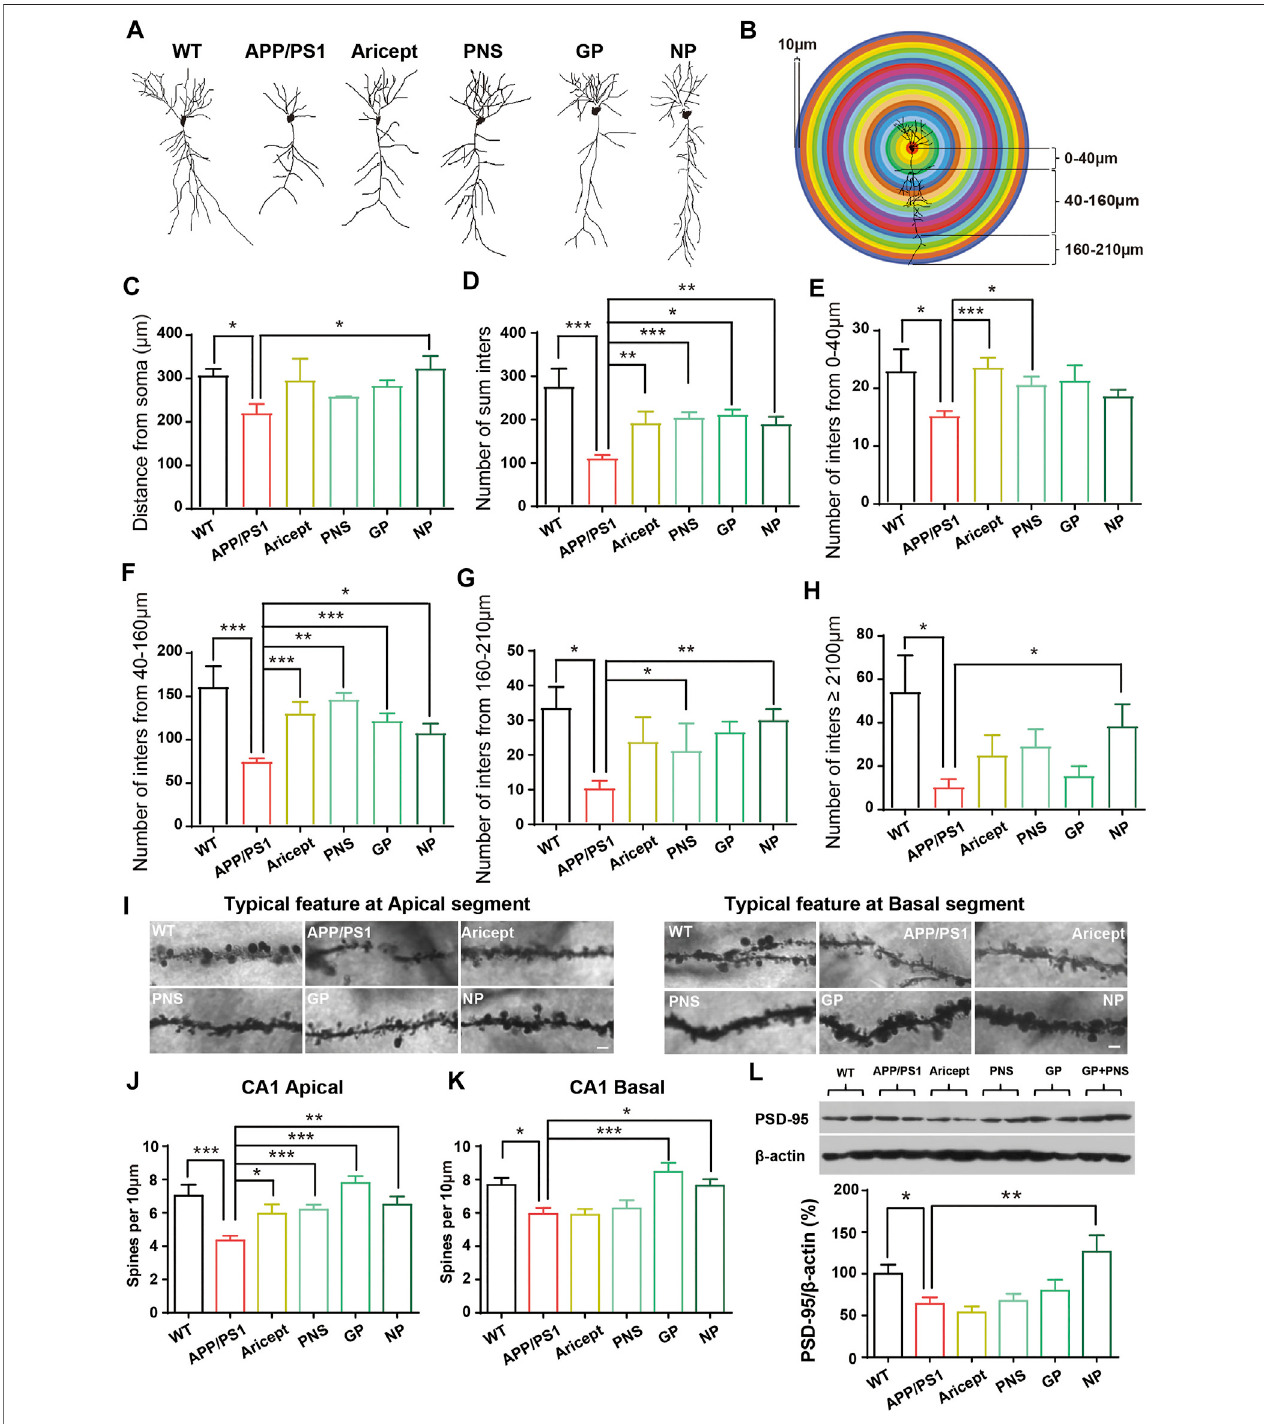
FIGURE 3 | Enhancement of the synaptic plasticity. (A) Typical feature of neurons by tracing analysis. (B) Experimental model for dendritic structure analysis. The numberofintersectionswascalculatedper10 µm. (C) Distancefromsoma. (D) Numberofintersectionsintotal. (E – H) Numberofintersectionsintherangeof0 – 40 µm, 40 – 160 µm, 160 – 210 µm, and more than 210 µm. (I) Typical feature of spines at CA1 apical and basal segments. (J – K) Number of spines at CA1 apical and basal segmentswasanalyzed. (L) ExpressionofPSD-95proteininthehippocampus.( n =5,Dataaremeans±SEM.ComparedwithAPP/PS1,* p < 0.05,** p < 0.01,and *** p < 0.001; one-way ANOVA, followed by Tukey ’ s multiple comparison test).